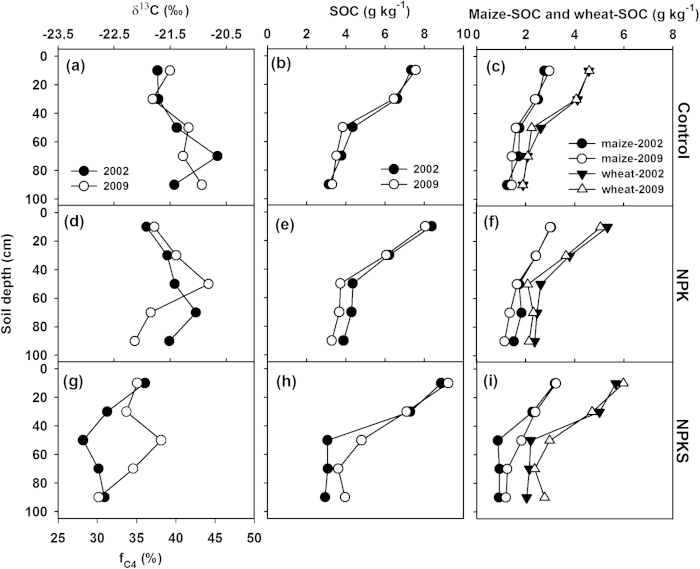
Vertical distributions of δ13C in SOC, fraction of maize derived SOC (fC4) (left column), total SOC (middle column), maize and wheat derived SOC (right column) under control (top row), NPK (middle row) and NPKS (bottom row) at Urumqi.